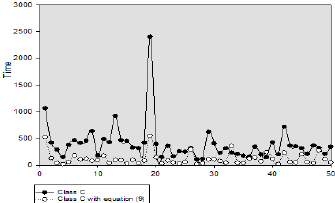
Fig. 7. Results of class B's validity analysis